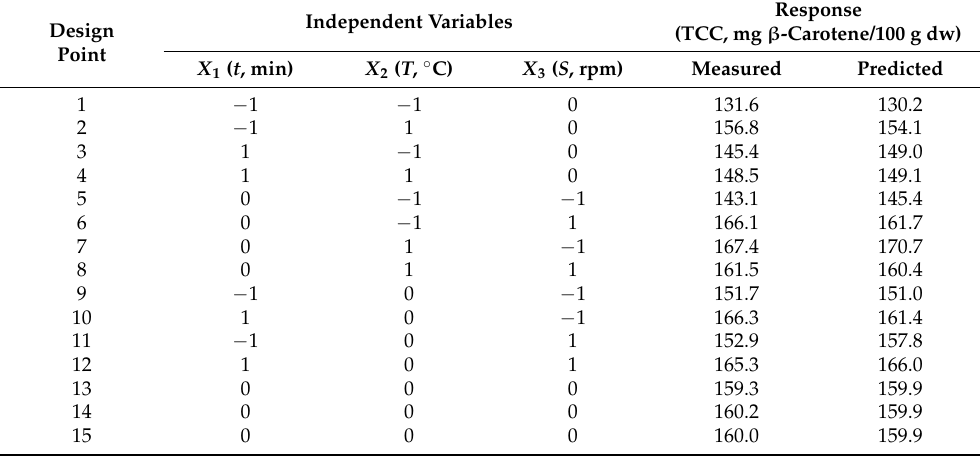
Table 4. The design points included in the experimental design, the corresponding coded values of the process variables, and the TCC values for the measured and predicted responses were optimized for APW extraction with n -hexane: acetone: ethanol (2:1:1)